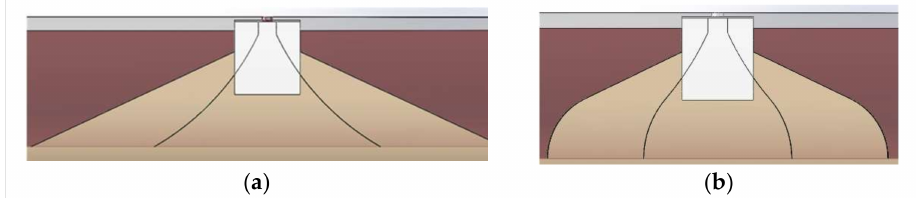
Figure 5. Optimized scheme 2: ( a ) before optimization; ( b ) after optimization.